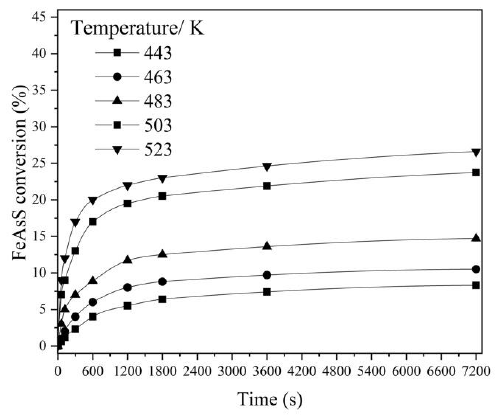
Figure 4. Effect of temperature on hydrothermal conversion of FeAsS (100 rpm; 0.1 mol/L of H 2 SO 4 ; 0.16 mol/L of Cu; 10 –29 μm).